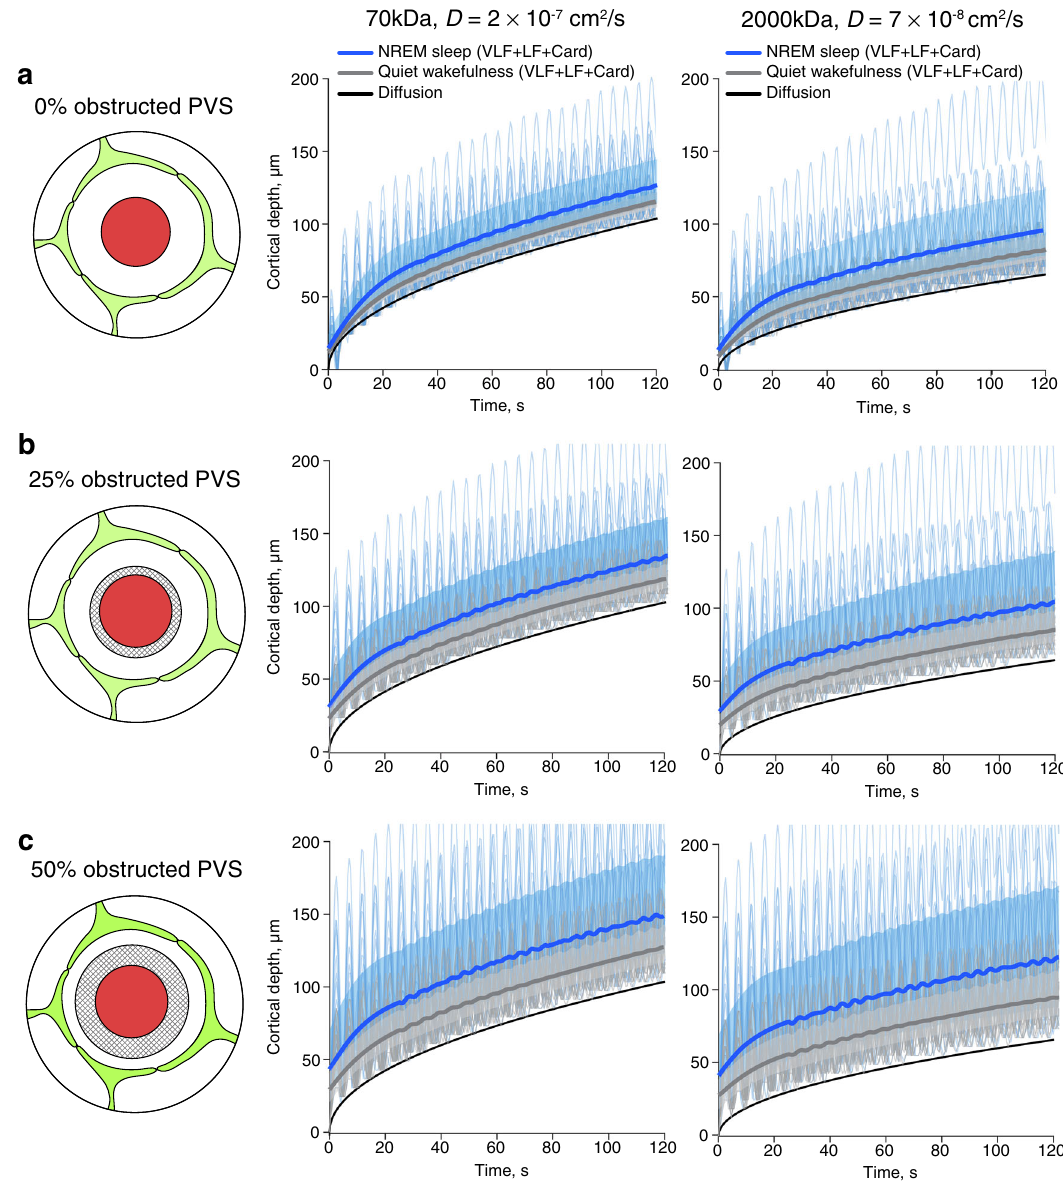
Fig.5|NREMslowvasomotionenhancespredictedsolutein fl ux.a – c In fl uxof70 and 2000 kDa solutes from the entrance of the penetrating arteriole PVS at the brain surface driven by dispersion during quiet wakefulness, dispersion during NREM sleep or purediffusion aspredicted bybiomechanicalmodeling using three scenarios where we added a fi xed volume to the PVS obstructing fl ow corre- sponding to 0, 25, and 50% of our measured PVS in quiet wakefulness. The model used themeasurementsofPVSsizeforLFandVLFoscillationsandassumedapeak